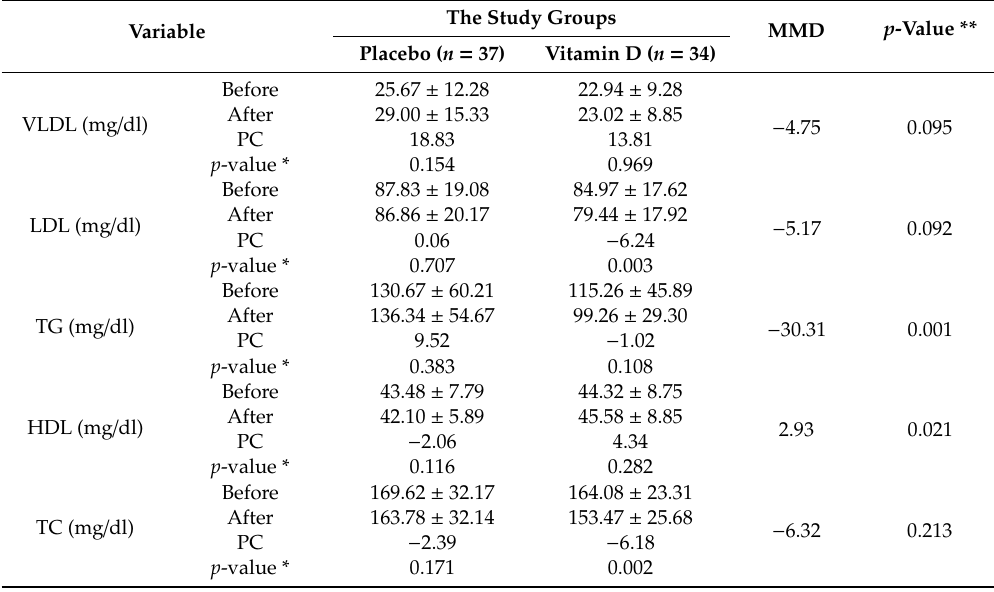
Table 4. Comparing the lipid profile in study groups before and after intervention.